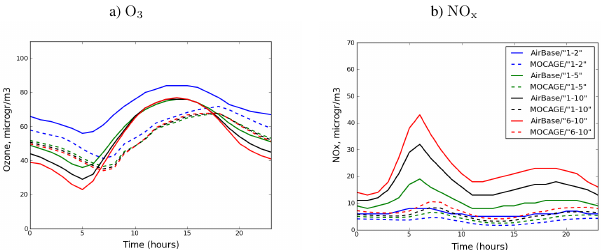
Fig.1. Meandiurnalcyclesof O 3 (left)and NO x (right),asafunctionofhour,simulatedwithMOCAGE Fig. 1. Mean diurnal cycles of O 3 (a) and NO x (b) , as a function of (dashed lines) and observed by AirBase averaged for the summer (JJAS) of 2007. Diurnal cycles are hour, simulated with MOCAGE (dashed lines) and observed by Air- represented for the classes 1–2, 1–5, 1–10 and 6–10. figure Base (solid lines) averaged for the summer (JJAS) of 2007. Diurnal cycles are represented for the classes 1–2, 1–5, 1–10 and